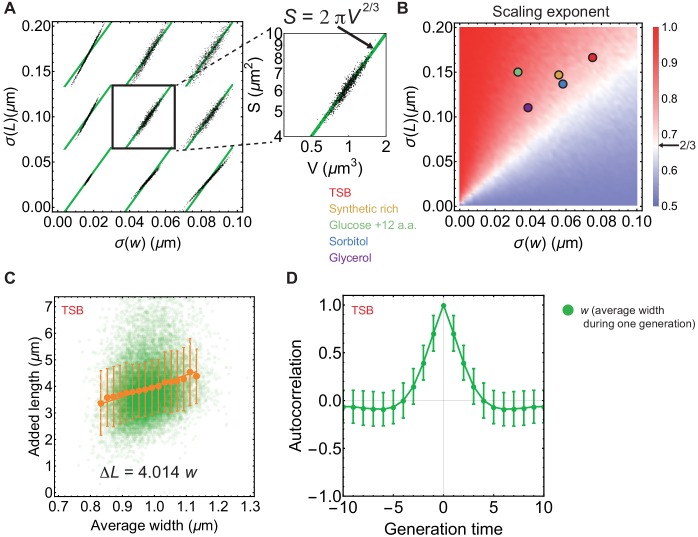
Deviation from average surface-to-volume scaling law, and correlation between added length and width from single-cell E. coli data.(A) Surface area vs volume for sphero-cylindrical bacterium, computed using normal distribution for cell widths (μw,σ⁢(w)) and log-normal distribution (μL,σ⁢(L)) of cell lengths. Green line is S=2⁢π⁢V2/3. (B) Surface-to-volume scaling exponent computed for different values of σ⁢(w) and σ⁢(L) while keeping L/w=4. For each pair of values (σ⁢(w), σ⁢(L)) we pick 104 random numbers from corresponding distributions and computed surface-to-volume scaling exponent. Total of 2500 pairs (σ⁢(w), σ⁢(L)) were used. We obtained σ⁢(w) and σ⁢(L) of newborn cells grown in mother machine by fitting experimental distributions. These values are shown by coloured points that correspond to different growth media (Taheri-Araghi et al., 2015). Large fluctuation in new born lengths for a given cell width results in scaling exponents slightly above 2/3, as expected. (C–D) Single cell data are obtained from Suckjoon Jun lab (UCSD) (Taheri-Araghi et al., 2015). (C) Single cell added length (Δ⁢L) vs average width (w) during one cell cycle for cell grown in TSB. Green circles represent single cell data, orange circles are average of binned data in width, error bars are ±1 standard deviation, and orange line is best fit to binned data (Δ⁢L=4.014⁢w). (D) Intergeneration autocorrelation function of average cell width during one cell cycle for cell grown in TSB. Once perturbed, cell width takes ≈4 generations to equilibrate to its steady state population average. Error bars: ±1 standard deviation.